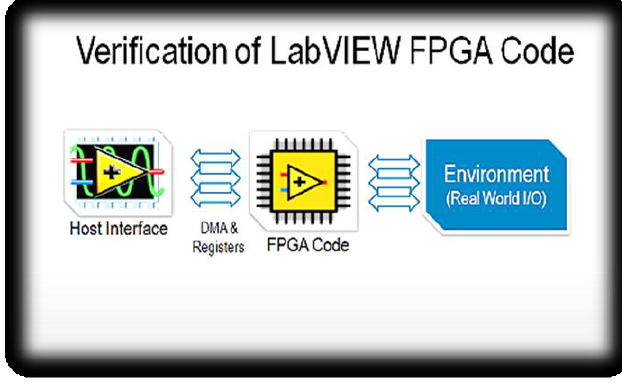
Fig. 4. Representative discrete logic diagram of RPS